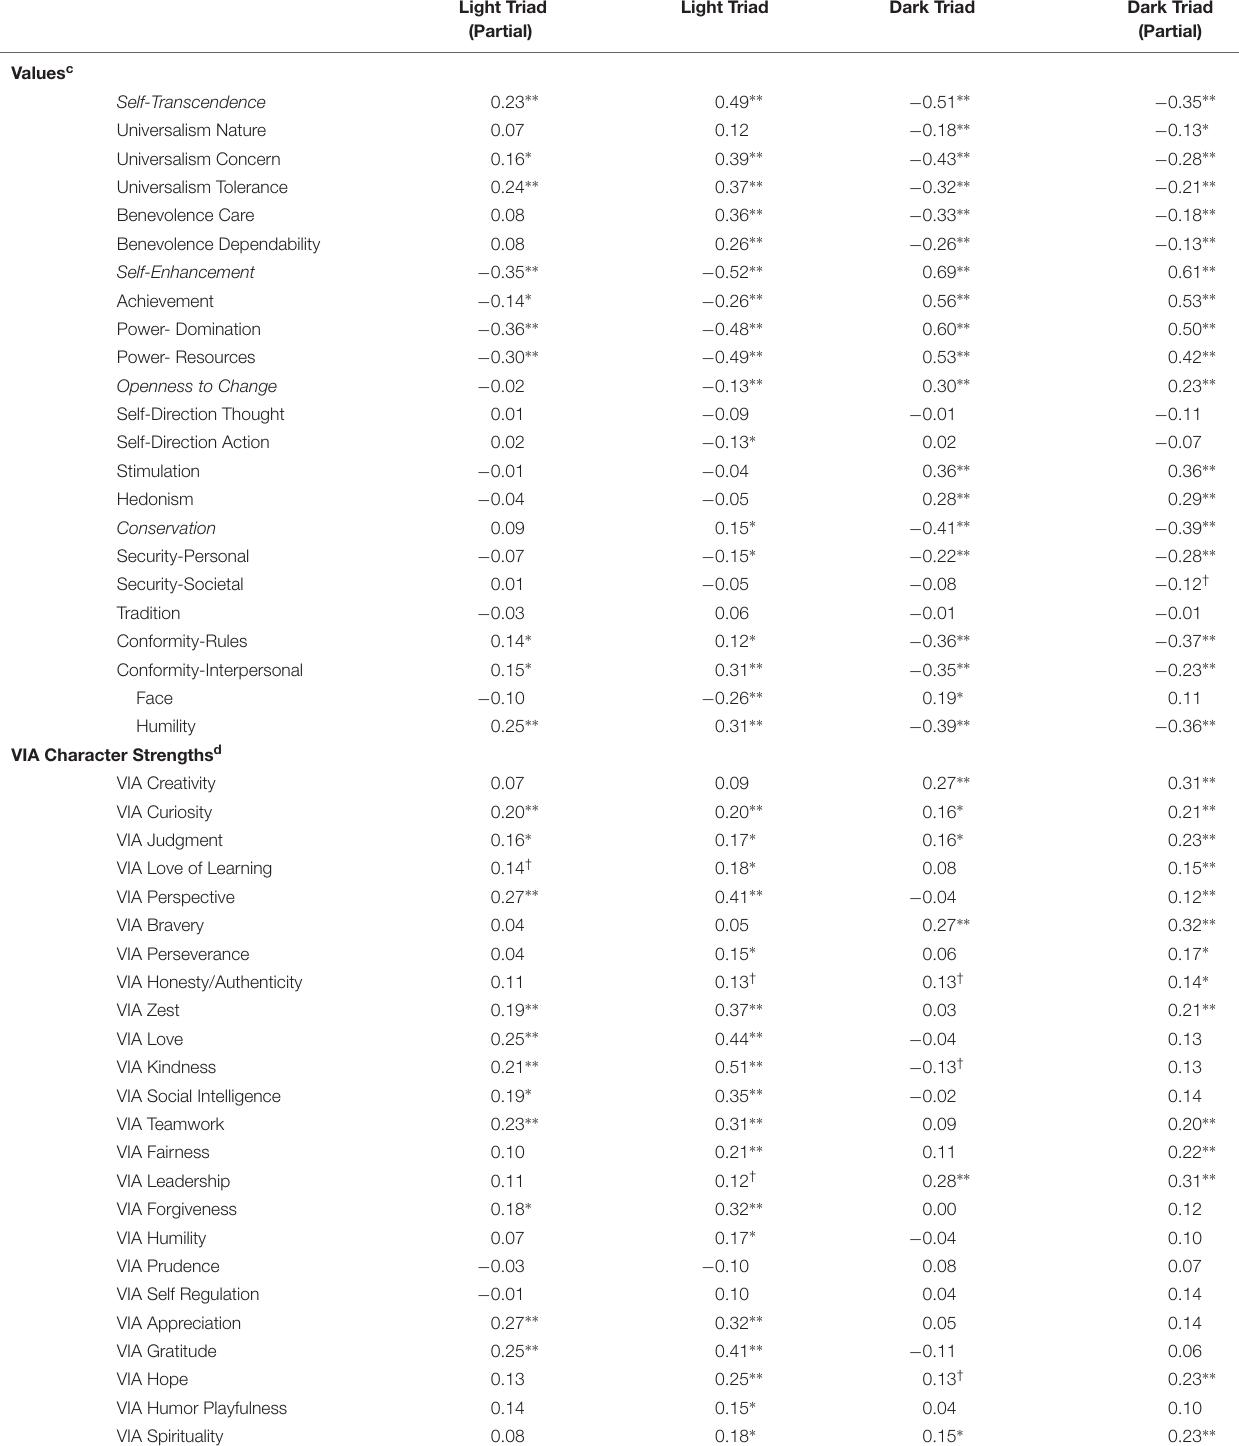
Light Triad Light Triad Dark Triad Dark Triad (Partial)